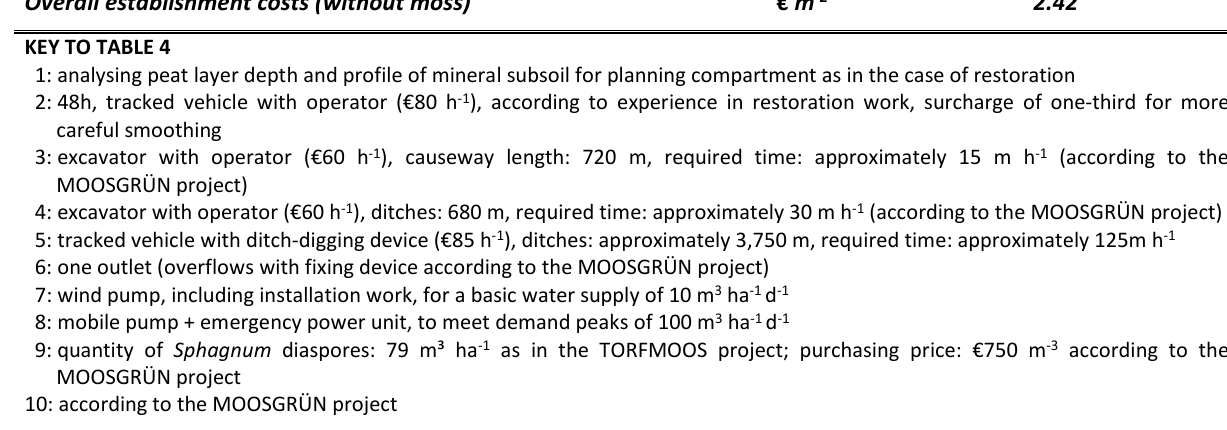
Table 4. Labour, machinery and investment costs of establishing Sphagnum cultures on a cut-over bog after milled peat extraction, at a fictional site (CO-PS 1) in Lower Saxony, Germany.